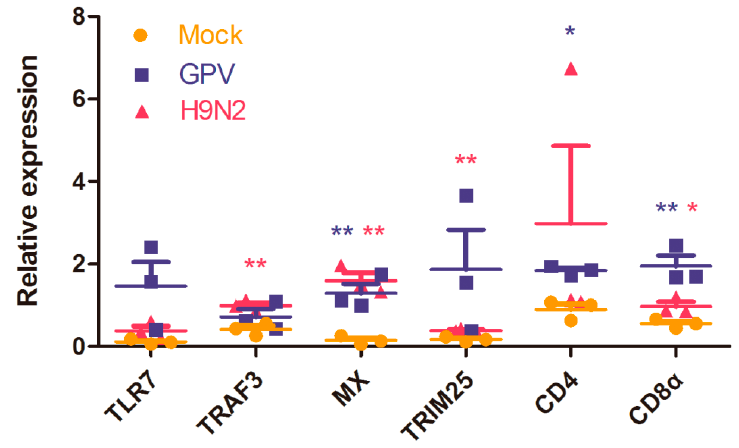
Figure 6. Expression profiles of six differentially expressed genes were verified by RT-qPCR. All of these genes play important roles in viral defense. The mRNA levels of these genes were increased after viral infection, a finding that was consistent with the altered expression profiles in the transcriptome data. Each dot represents a goose individual and different colors show different experimental groups (saffron yellow, blue, and pink represent mock-, GPV-, and H9N2-infected groups, respectively). Data are represented as the mean ± SEM. * p ≤ 0.05, ** p ≤ 0.01.